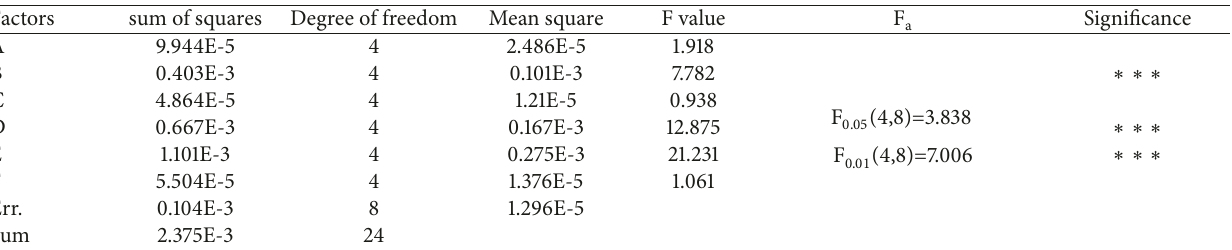
Table 5: Results of variance